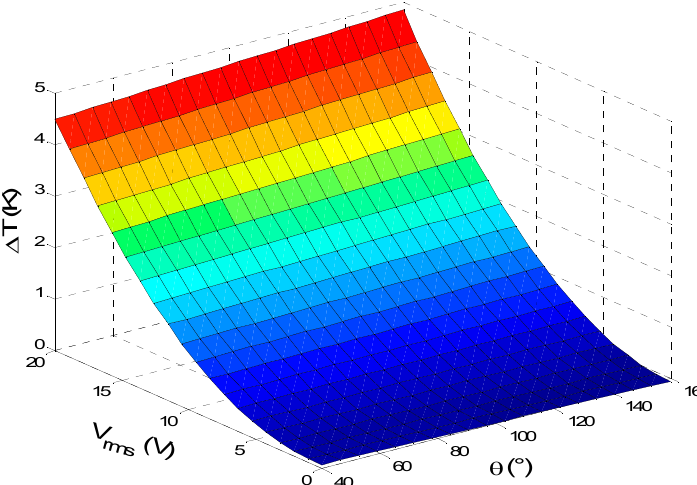
Figure 7. Surface plot of temperature rise versus the applied voltage V rms and the electrode angle α = θ . The average inlet velocity is fixed at 100 μ m/s.